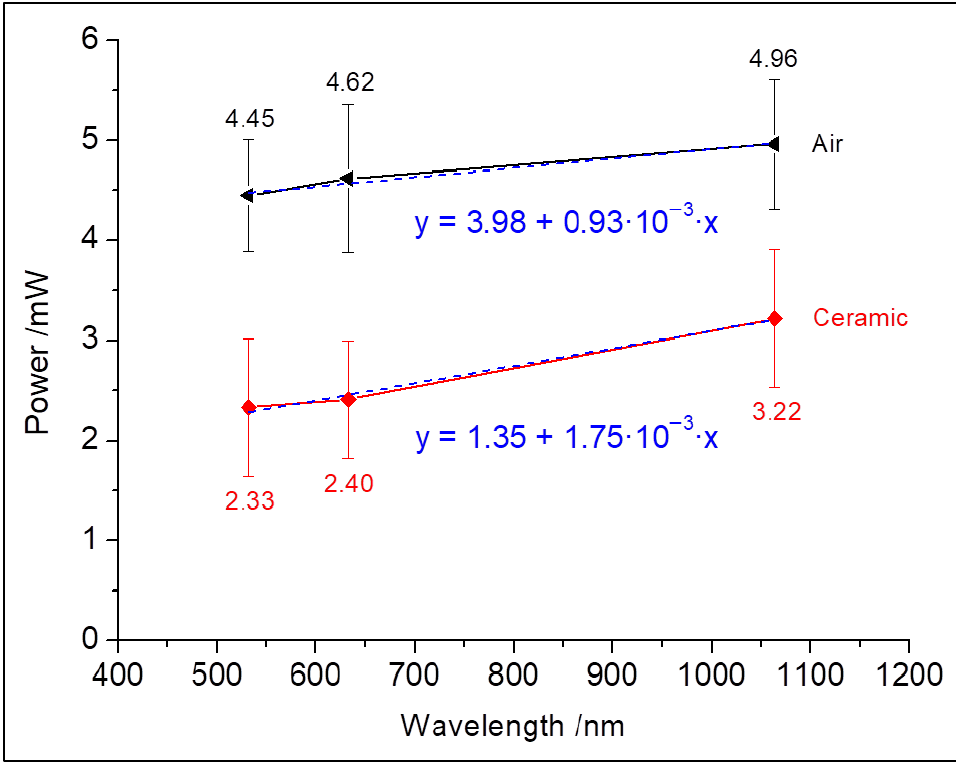
Figure 3. Adaptation of the laser output powers to the He-Ne laser (632.8 nm) in air (upper graph) as well as at the transmitted powers of all laser through the ceramic base model (lower graph). Also shown are the corresponding gradients of both graphs.